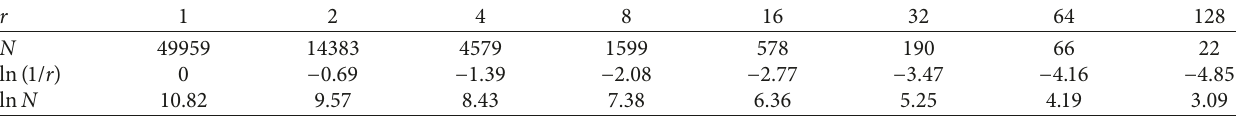
(mining face 5-1 at a mining length of f